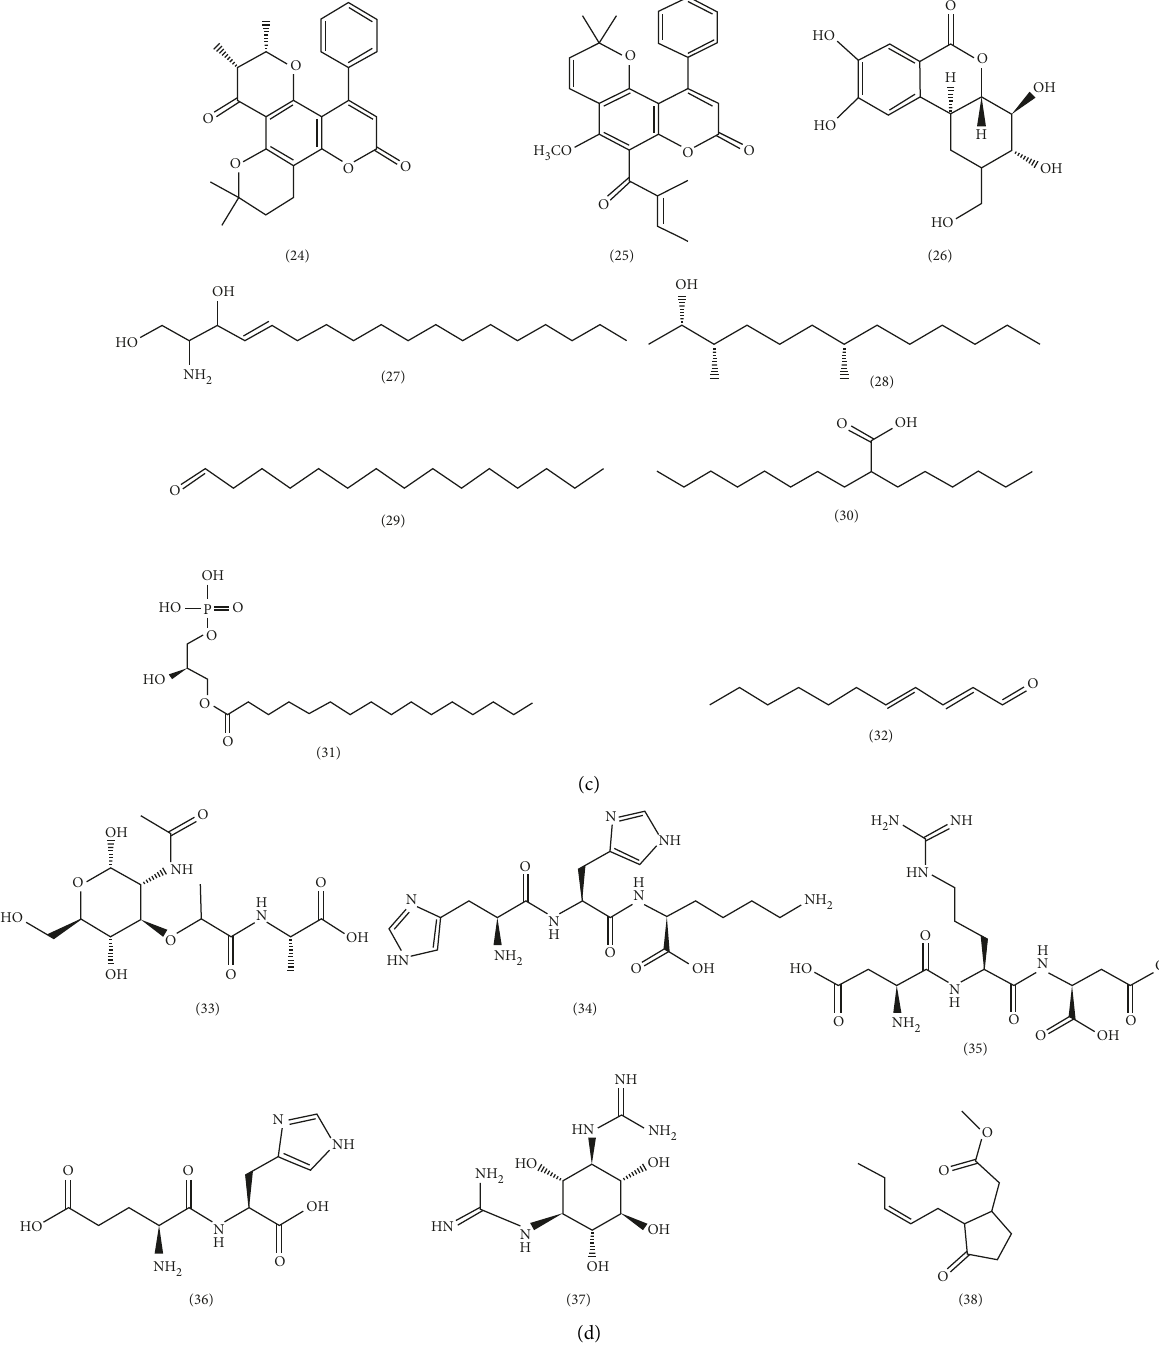
Figure 4: (a) Structure of some isolated alkaloids and glycosides from different parts of R. hypocrateriformis . (1) Macrophylline, (2) meteloidine, (3) symlandine, (4) cochlearine, (5) darlingine, (6) tigloidine, (7) serratanidine, (8) (i) hypocretine 1 and (ii) hypocretine 2, (9) pyrimethanil, (10) bergenin, (11) norbergenin, (12) (i) rivebergenin A and (ii) rivebergenin B, (13) lucuminic acid, (14) oleandrose. (b) Structure of some isolated flavonoids, xanthones, and stilbenes from different parts of R. hypocrateriformis . (15) Quercetin, (16) 3 ′ - deoxymaysin, (17) 6-C-glucopyranosylpilloin, (18) peruvianoside II, (19) morusin, (20) dulciol B, (21) mangostenone B, (22) blestriarene B, and (23) α -viniferin. (c) Structure of some coumarins, fatty acids, and sterols from different parts of R. hypocrateriformis . (24) Tomentolide A, (25) calophyllolide, (26) desmethylbergenin hemihydrate, (27) sphingosine, (28) 3S, 7S-dimethyl-tridecan-2S-ol, (29) pentadecanal, (30) 2-hexyl-decanoic acid, (31) 1-palmitoyl lysophosphatidic acid, and (32) 2, 4-undecadienal. (d) Structure of some isolated other organic compounds from different parts of R. hypocrateriformis . (33) N-acetylmuramoyl-alanine, (34) his-his-lys, (35) asp-arg-asp, (36) glu-his, (37) streptidine, and (38)